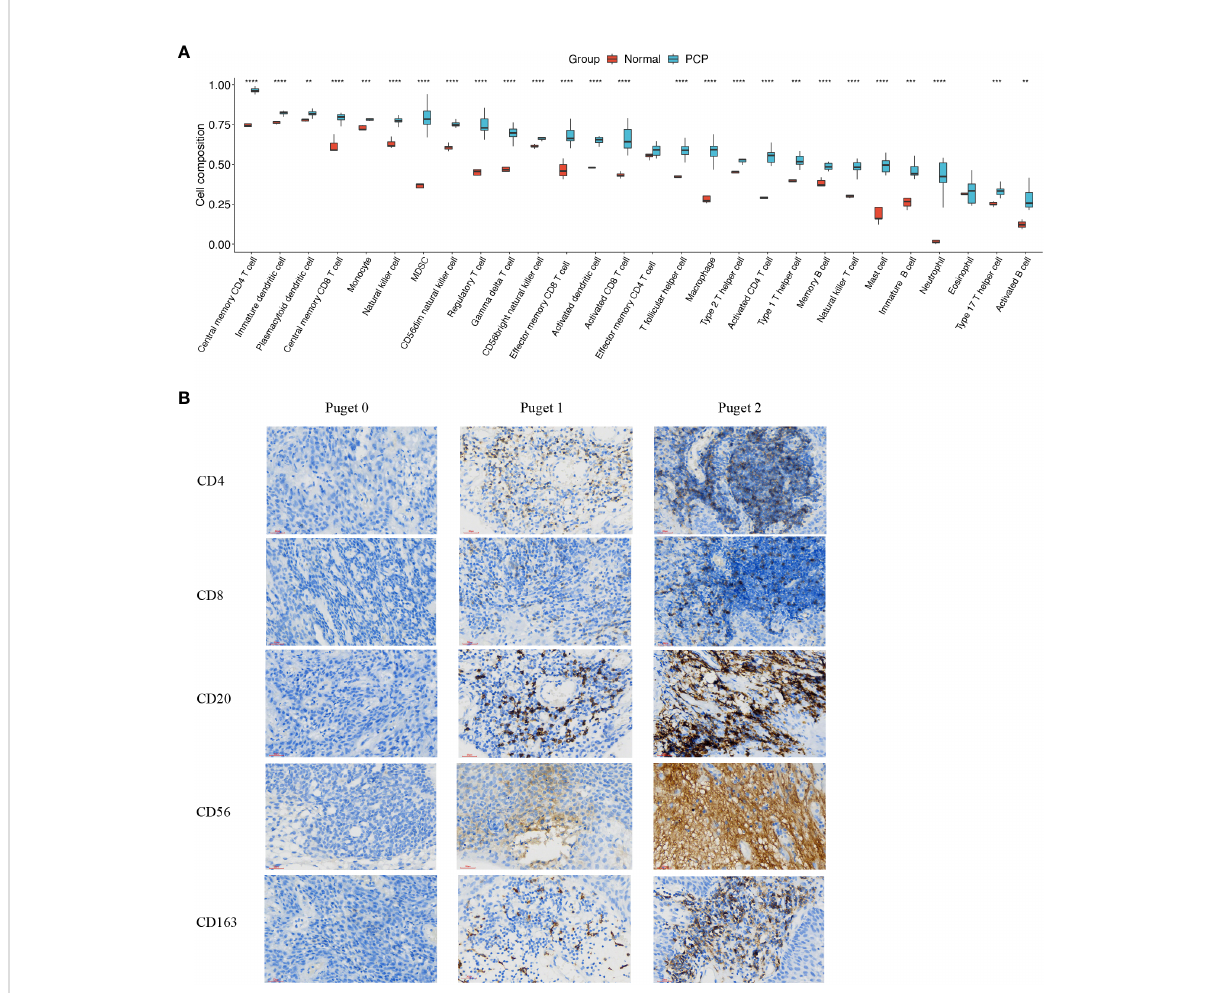
FIGURE 2 In fi ltration of immune cells in PCP tumor. (A) Twenty-eight subtypes of tumor-in fi ltrating immune cells in PCP tumor samples compared with those in normal brain tissues. The following symbols indicate statistical signi fi cance: blank: p > 0.05; ** p ≤ 0.01; *** p ≤ 0.001; **** p ≤ 0.0001. (B) Immune historical staining of 5 immune cell biomarkers in PCP samples of different Puget groups,